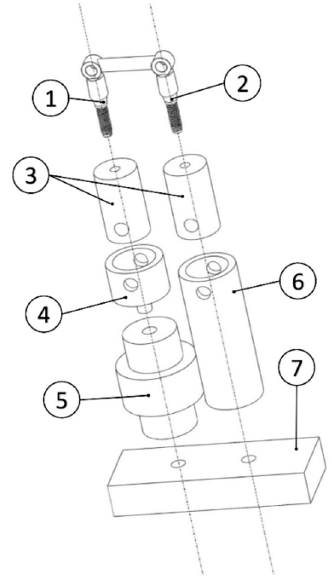
Figure 2. Specimens support: ( 1 ) the most retentive abutment (i.e., abutment 1 in Table 1), ( 2 ) the least retentive abutment (i.e., abutment 2 in Table 1), ( 3 ) implants holders, ( 4 ) connection between the holder of the most retentive abutment and the load cell, ( 5 ) load cell, ( 6 ) connection between the other implant holder and the base, ( 7 ) rectangular base.